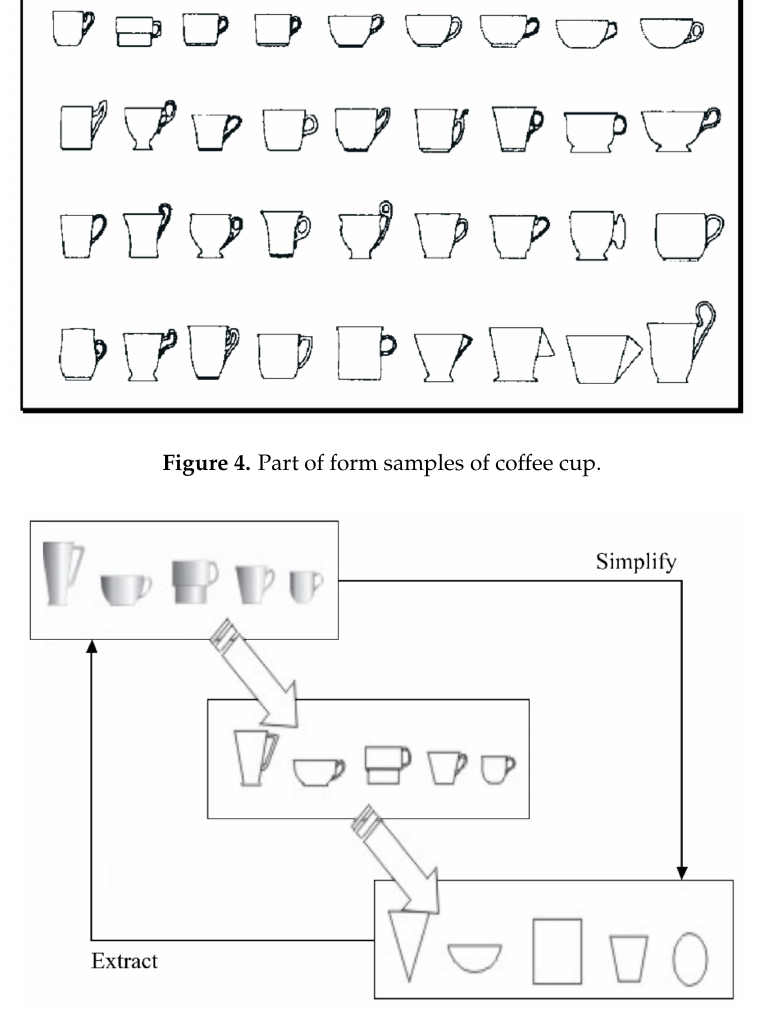
Figure 5. Extract coffee cup: the process of using digital signal process (DSP) technology to conduct the extraction of form factors F i